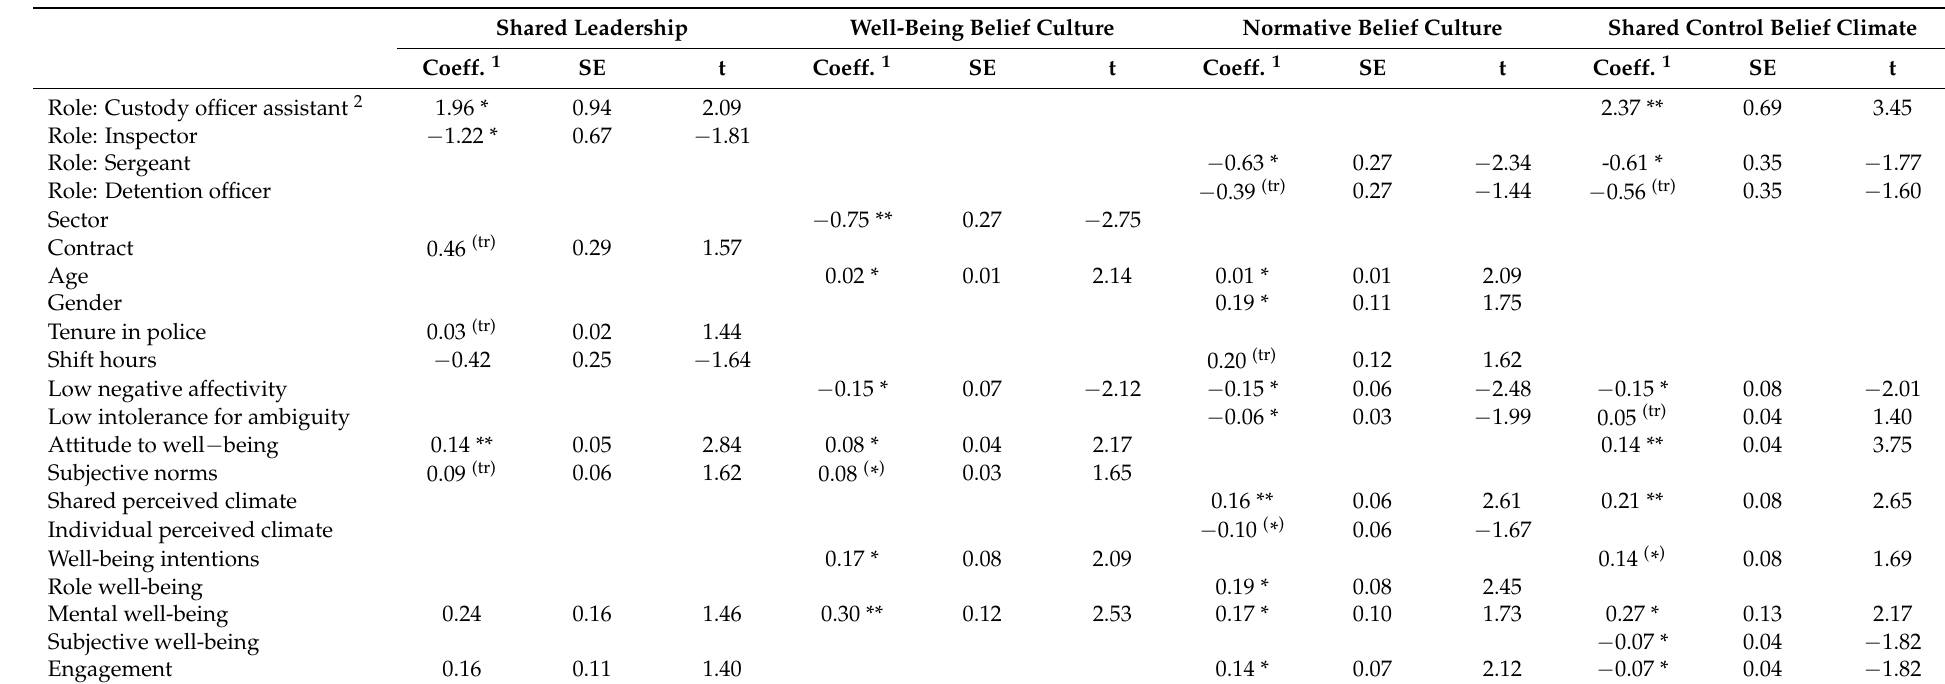
Table 3. Fixed effect outcomes for indirect measures and predictor